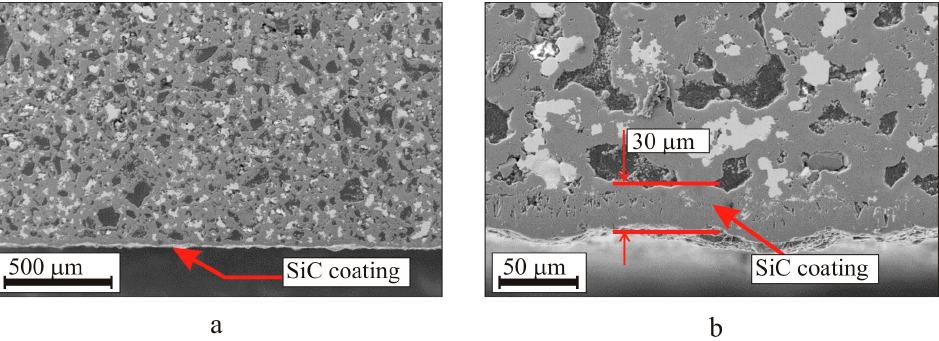
Figure 13. Micrograph of the structure of a SiC-C-MoSi 2 ceramic composite material with a protective SiC coating: black areas represent carbon, dark gray represents SiC, and light gray represents MoSi 2 . ( a ) low magnification; ( b ) high magnification.